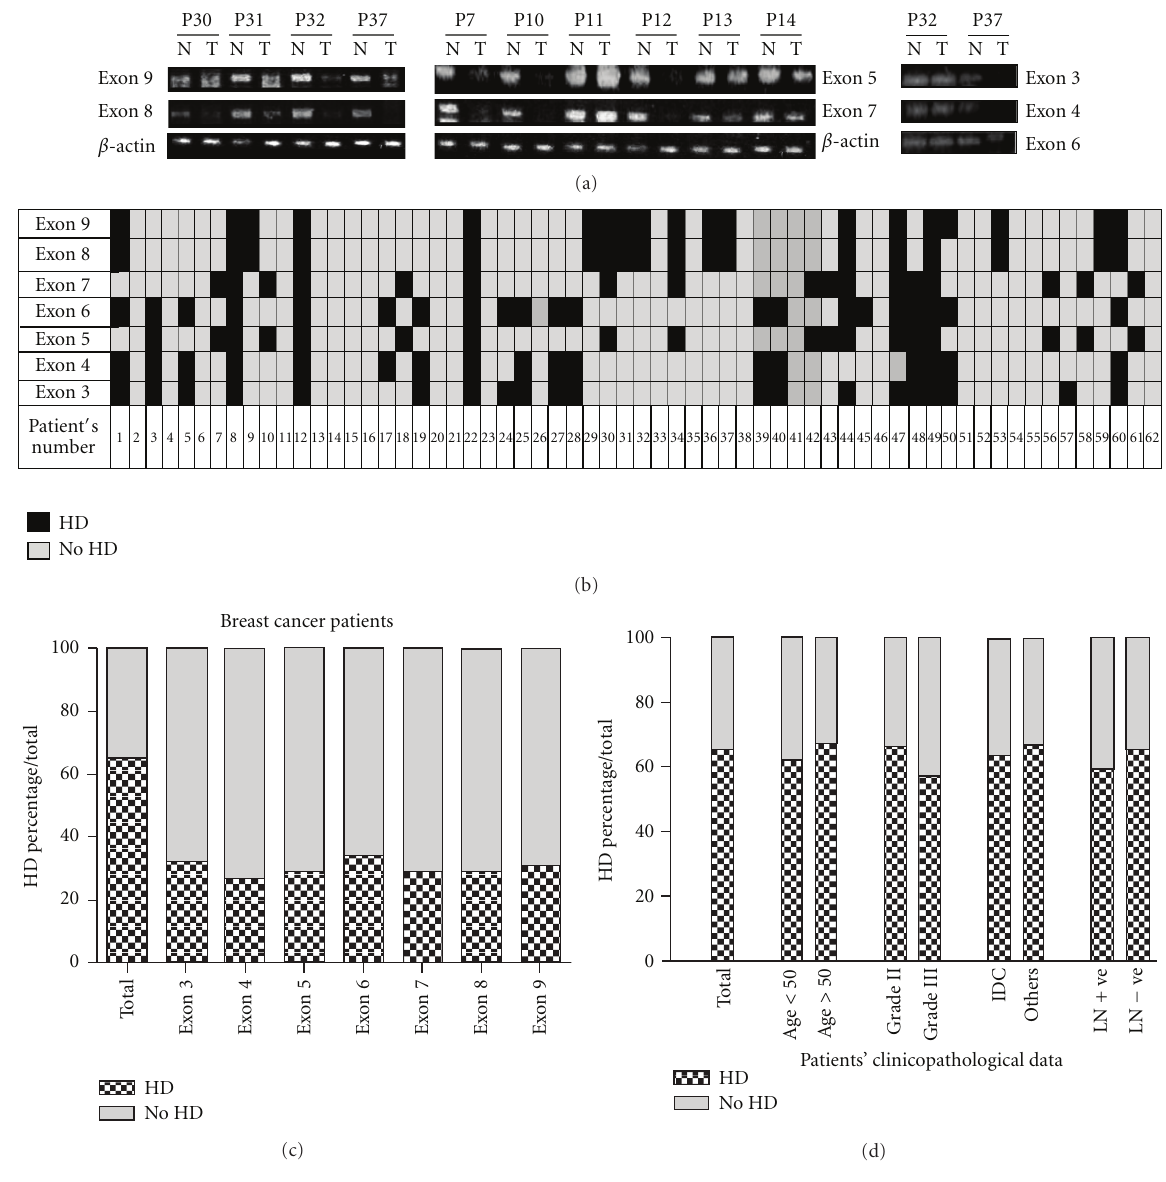
Figure 1: FHIT gene exons are subjected to homozygous deletions in Egyptian neoplastic and preneoplastic breast tissues. DNA was extracted from breast cancer and matched normal tissue samples then subjected to PCR analysis of FHIT exons. (a) Amplification of exons 3, 4, 5, 6, 7, 8, and 9. β -actin was used as a control for equal amount of DNA used in the amplification. Intensity of amplified band in tumour (T) samples was compared with its relative one in normal sample (N). Samples that showed significant reduction or loss of the amplified exons were considered positive for exon homozygous deletion (HD). (b) Cumulative data of HD in individual patients. (C) Incidence of HD of FHIT exons in breast cancer patients. (c) Incidence of HD of FHIT exons in breast cancer patients. (d) Association between HD of FHIT exons and breast cancer patients’ clinicopathological